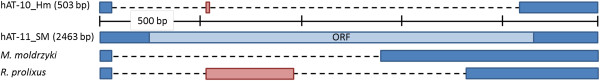
Relationships among hits highly similar to hAT-10_Hm in other taxa. Comparisons are to hAT-11_SM, the consensus sequence of a known autonomous DNA transposon from the planarian, Schmidtea mediterranea, and contigs from M. moldrzyki and R. prolixus. Blue boxes exhibit high similarity within the corresponding regions. Red boxes found for H. melpomene (nine bases) and R. prolixus (410 bases) indicate regions with no similarity to any corresponding sequence in the other taxa. Contig IDs and sequence similarity values are available from the text.